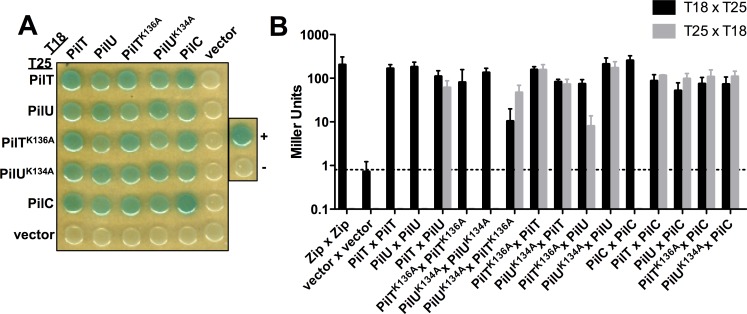
PilT and PilU interact with each other and the pilus platform protein PilC.Bacterial Adenylate Cyclase Two-Hybrid (BACTH) assays were performed to test pair-wise interactions between full length PilT, PilU, PilTK136A, PilUK134A, and PilC that were N-terminally fused to the T18- and T25- fragments of adenylate cyclase. Each construct was also tested for interactions with empty T18 and T25 vectors as a negative control. Leucine zipper fusions to T18 and T25 were used as the positive control (+) and empty T18 and T25 vectors served as an additional negative control (-). (A) Representative image of the BACTH assay plated on X-gal-containing media. (B) BACTH miller assays of the indicated pairwise interactions. The dotted line represents the β-galactosidase activity of the empty vector negative control. Data are shown as the mean ± SD and are from three independent experiments. Statistical analysis of these data can be found in S2 Fig.